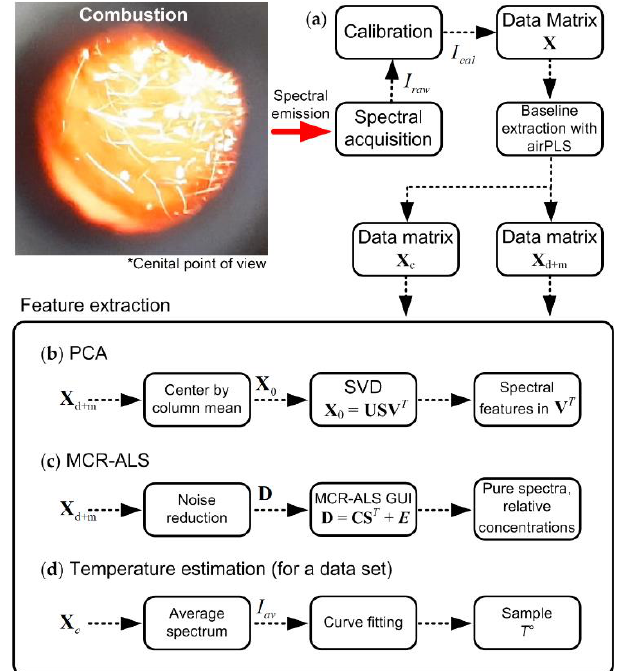
Figure 3. Data processing and analysis schemes implemented in this work: ( a ) Spectral signals acquisition and pre-processing, ( b ) PCA decomposition, ( c ) MCR-ALS implementation, ( d ) temperature estimation. ( d ) temperature